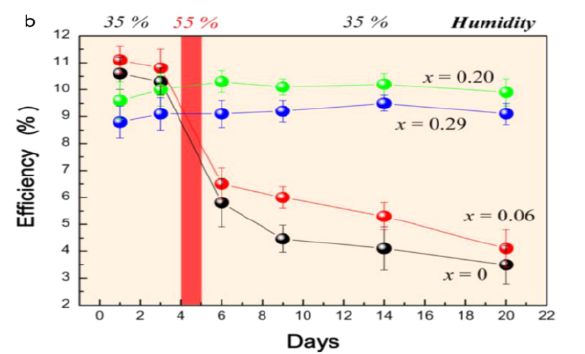
Figure 7: The effect of the stoichiometry of the perovskite MAPb(I1- xBrx)3 layer on the stability of the devices [21]